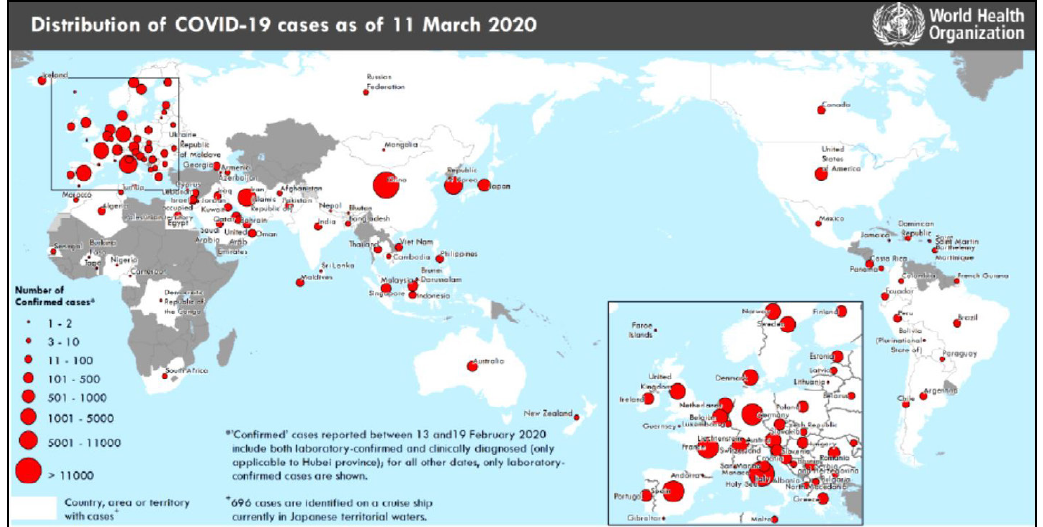
Fig. 2: Countries, territories or areas with confirmed reported cases of COVID-19 as of the 11 th of March 2020 (WHO, 2020b)